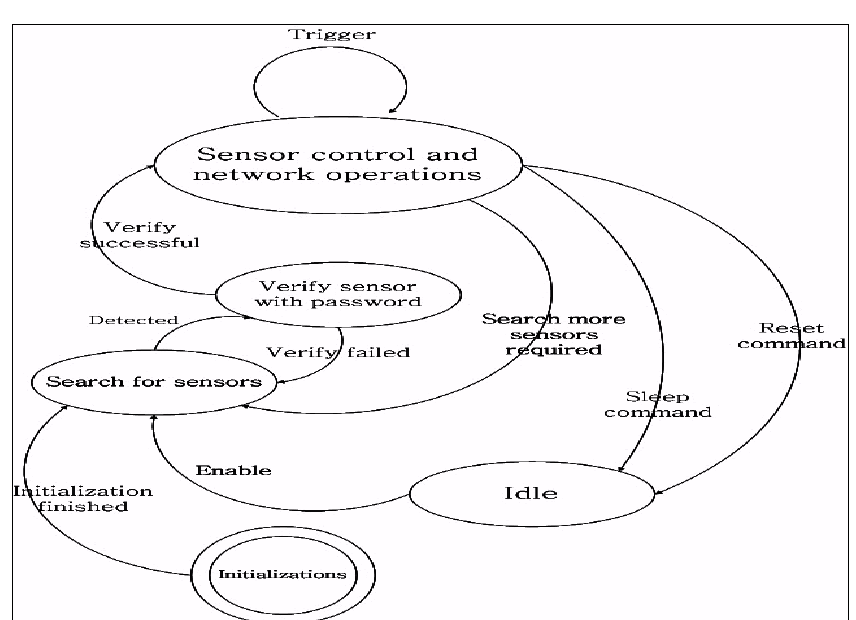
Figure 4 . Mobile device